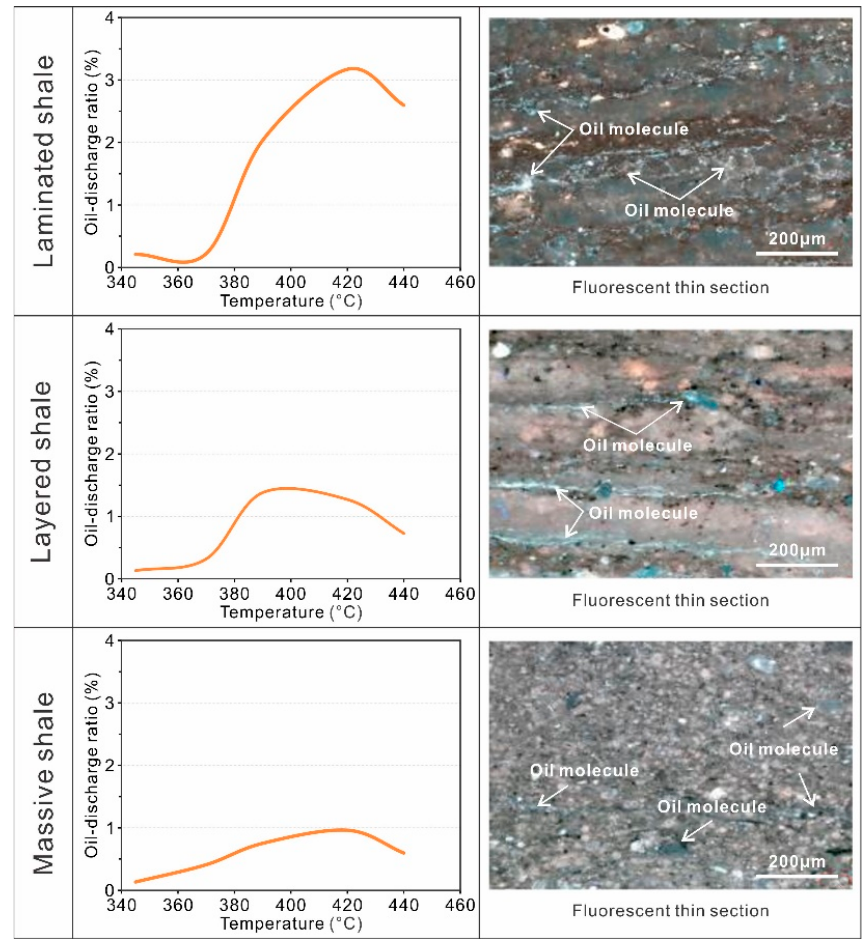
Figure 6. Oil-discharge ratio and hydrocarbon retention characteristics for different types of shale. Modified after [29,121].